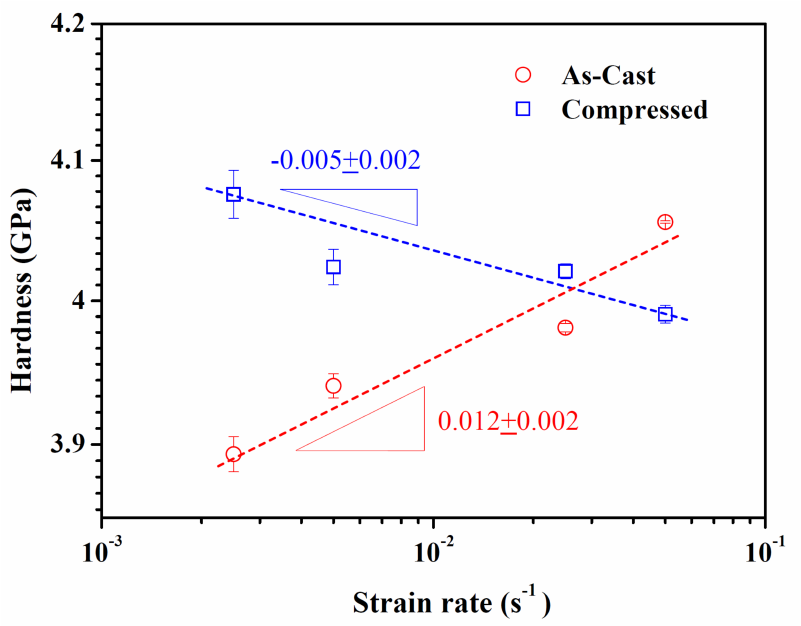
Figure 2. Strain rate dependence of hardness from nanoindentations of as-cast and compressed specimens. The slope of the fitted relations (dashed lines) demonstrates the strain rate sensitivity (m).